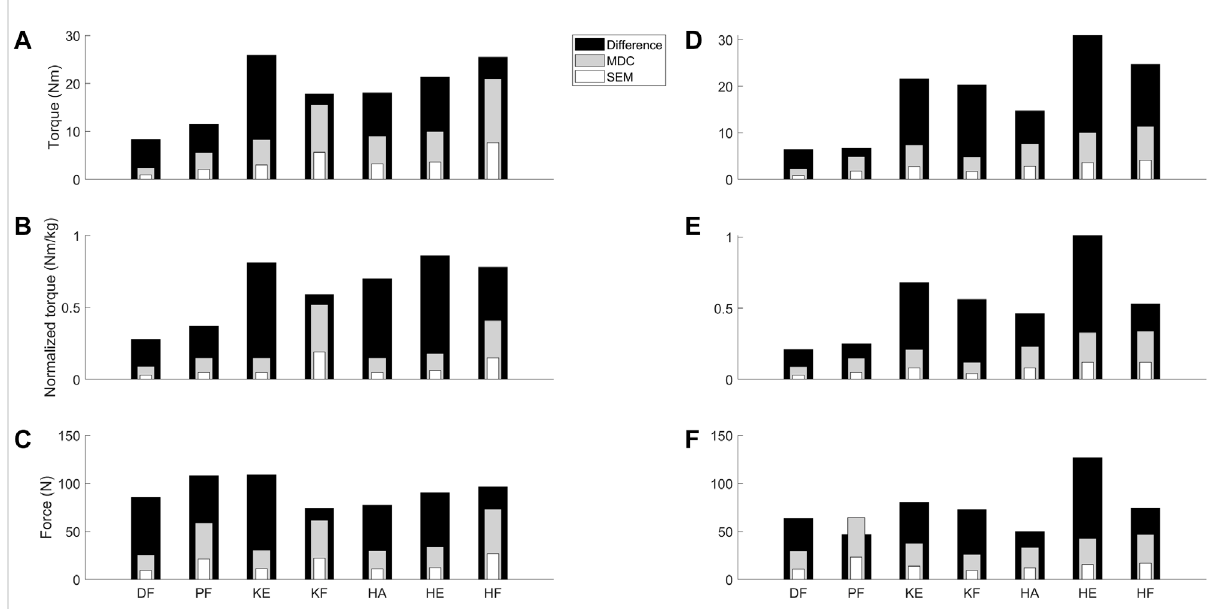
FIGURE 3 Visual representation to compare the absolute SEM (white) and MDC (grey) values as retrieved from the reliability study for thechildren with CP and DMD with the absolute differences between the median values of TD children and the clinical cohorts (black) from the validity study. Panel A – C visualize the data for torque (A) , normalized torque (B) and the force (C) in the children with CP. Panel D – F visualize the data for the torque (D) , normalized torque (E) and theforce (F) inthechildren with DMD. Abbreviations inalphabetical order:CP, cerebral palsy; DF,dorsi fl exion; DMD, Duchenne musculardystrophy; HA,hipabduction;HE,hipextension;HF, hip fl exion;KE, knee extension; KF,knee fl exion; MDC, minimaldetectable change; N,Newton; Nm, Newton meter;Nm/kg, Newton meterper kilogram bodyweight; PF,plantar fl exion; SEM,standard errorof measurement; TD, typically